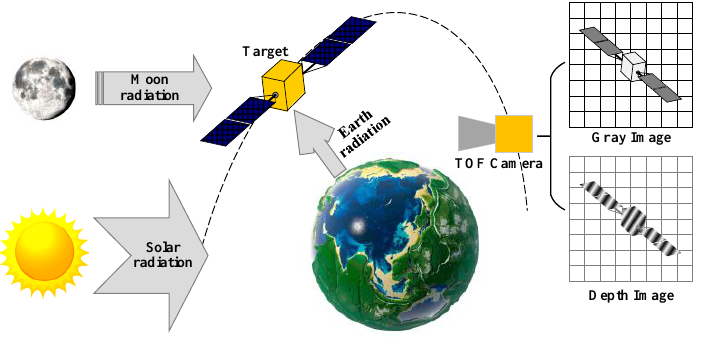
Figure 5. Physical radiation model of space targets.